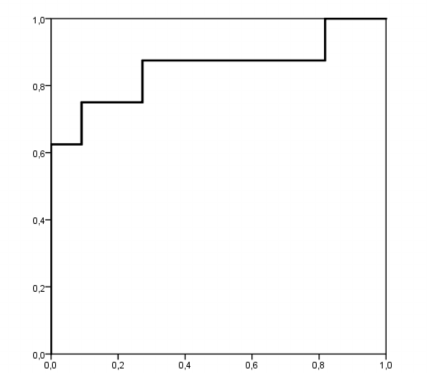
Figure 2. Receiver operating characteristic (ROC) curve analysis for body fat as a risk factor for lower back pain. The area under the curve is 0.852 ( p = 0.01); the coordinates represent a possible cuto ff point in body fat (the optimal cuto ff point was 23%).